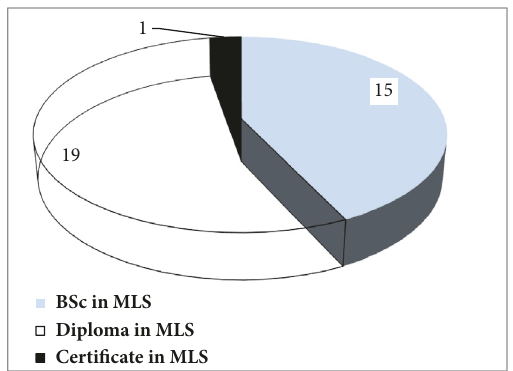
Figure 2: Staff profile working in nine health facility laboratories in zone one of Afar region, Ethiopia. Figure key: B.S. degree